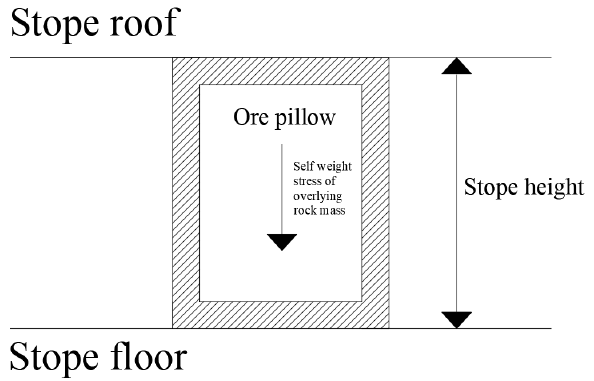
Figure 1. Schematic diagram of pillar stress.